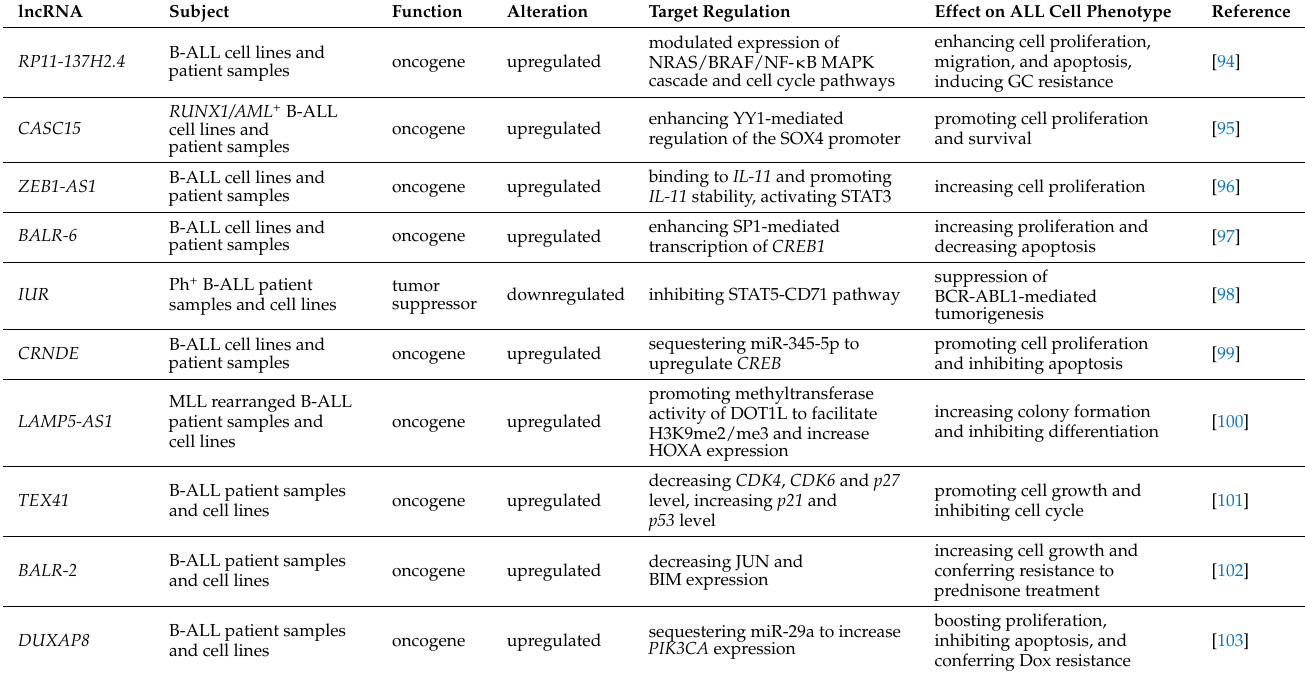
Table 2. List of lncRNAs implicated in B-ALL pathogenesis and treatment.